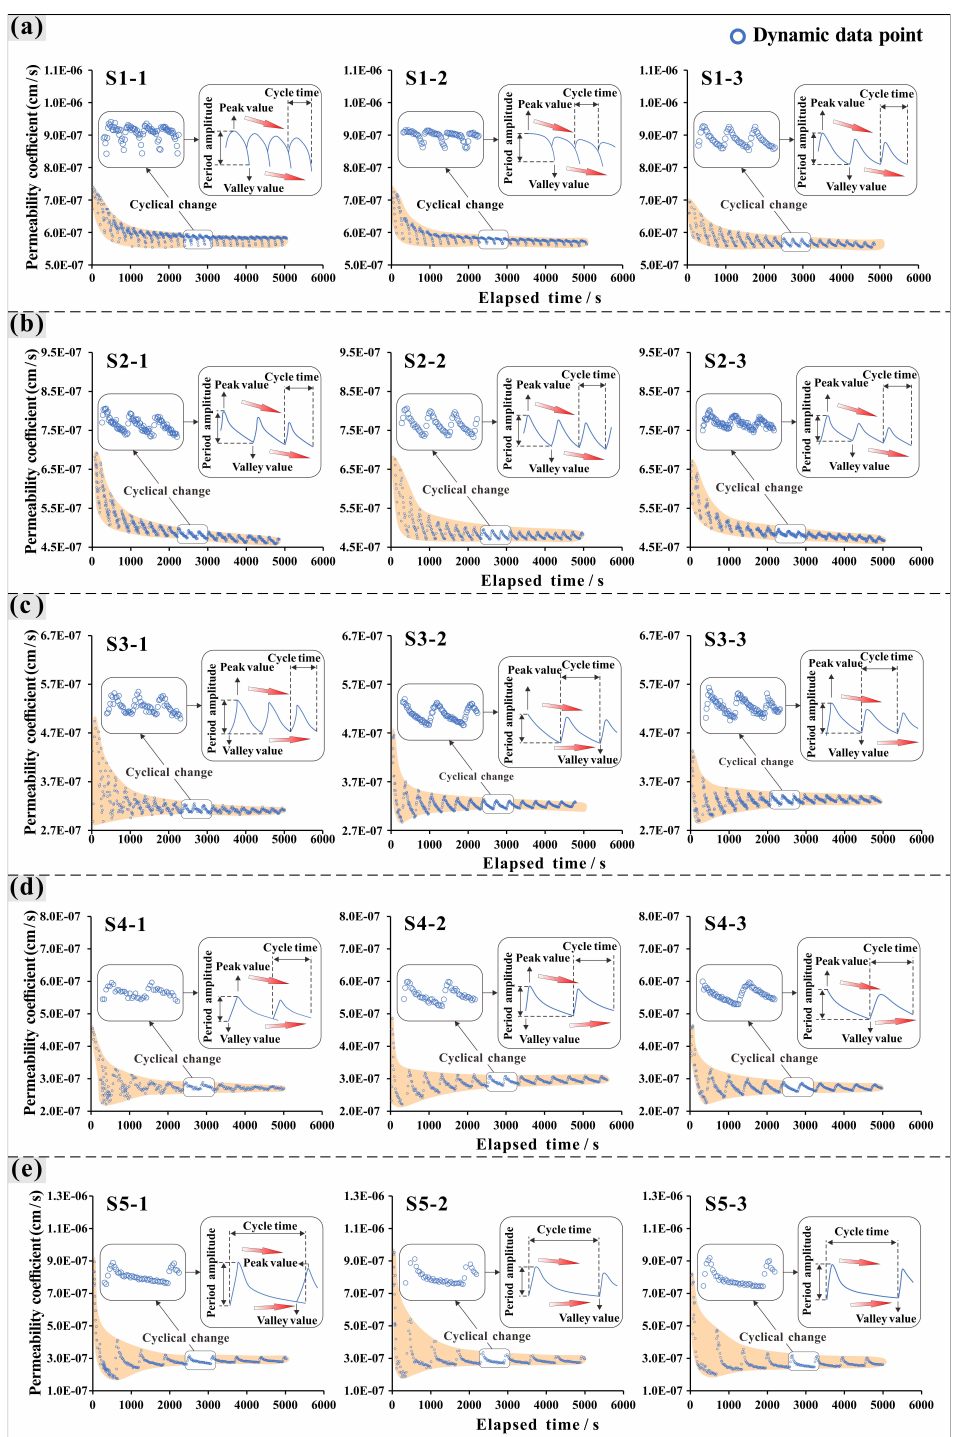
Figure 4. Evolution and statistics (per 1000 s) of permeability coefficients. ( a – e ) corresponding soil sample